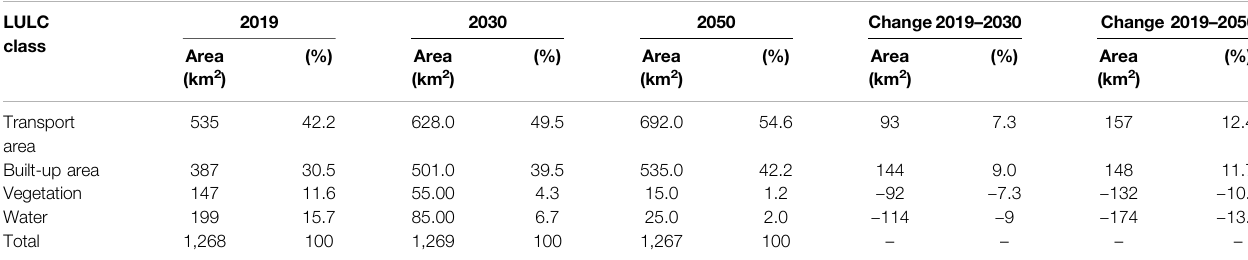
TABLE 7 | Transition area statistics of predicted LULC areas in 2030 and